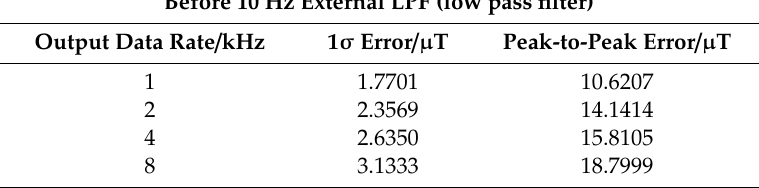
Table 5. Noise performance figures of the calibrated output from the instrument at di ff erent output data